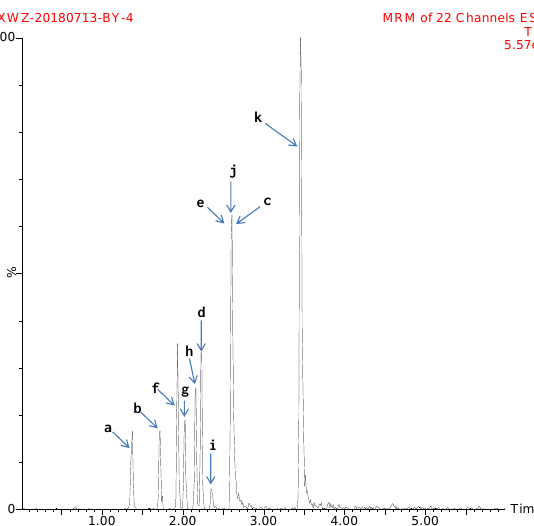
Figure 1. Total ion chromatogram (TIC) of compounds in a representative sample (a: gallic acid; b: chlorogenic acid; c: vanillin; d: ferulic acid; e: gallogen; f: rutin; g: isoquercetin; h: quercitrin; i: baicalin; j: quercetin; and k: kaempferide). Table 1. The multiple reaction monitoring (MRM) conditions of 11 polyphenols.